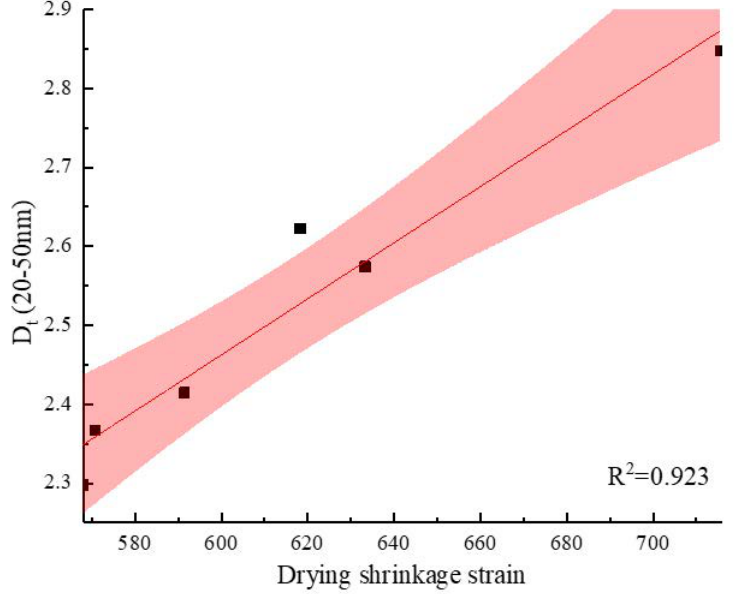
Figure 18. Relationship between D t and shrinkage